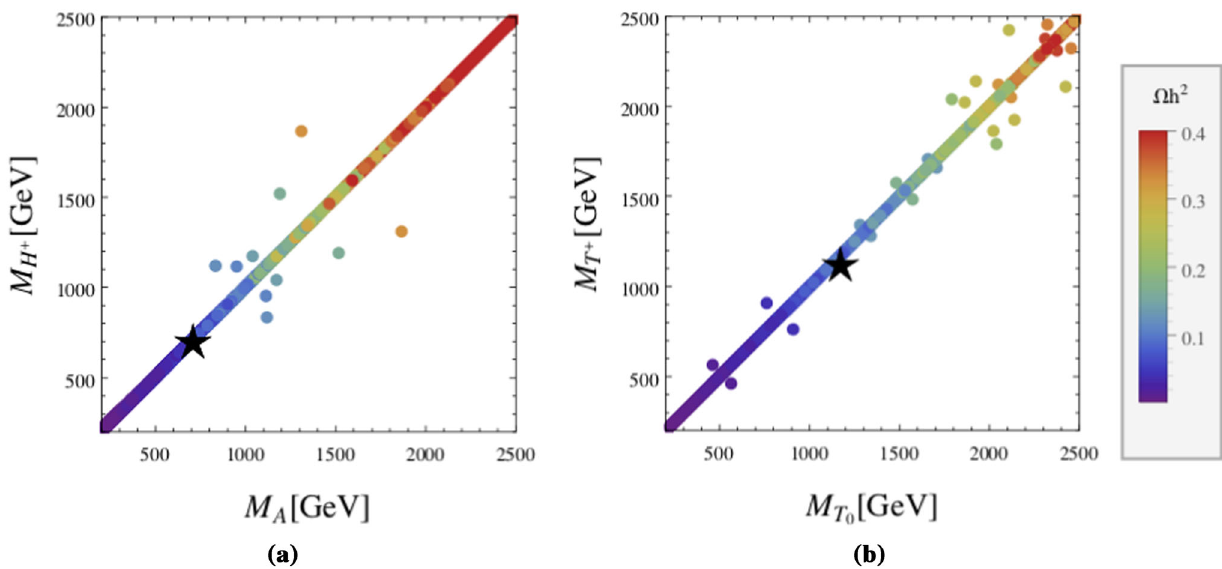
Fig. 10 3D plot describing the variation of relic density with dark mat- ter mass and charged Higgs boson mass in GeV. a IDM, b ITM. The correct relic density corresponds to DM mass (cid:2) 700 GeV in IDM and